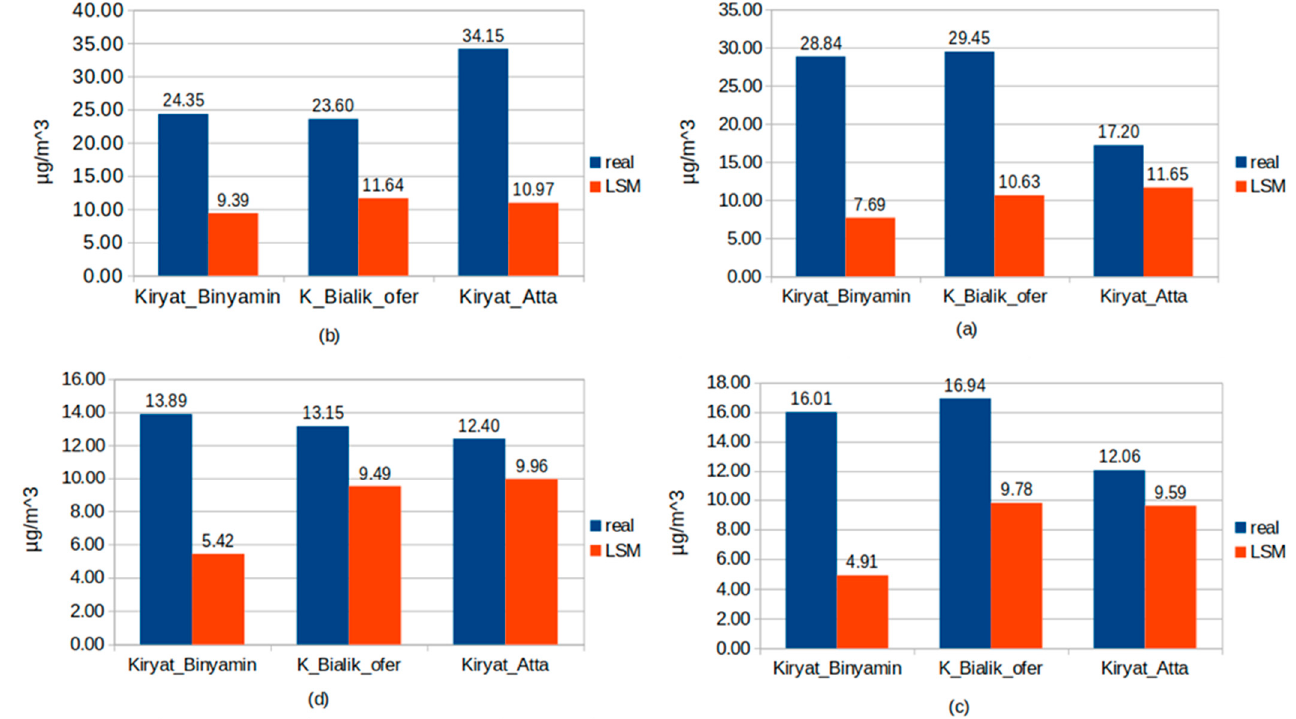
Figure 5. Comparison of the PM concentrations calculated by the LSM to measurements. ( a , b ) refer to PM10 concentrations in typical morning and evening conditions, respectively. ( c , d ) are similar to ( a , b ) in terms of the meteorological conditions, but for PM2.5 concentrations.